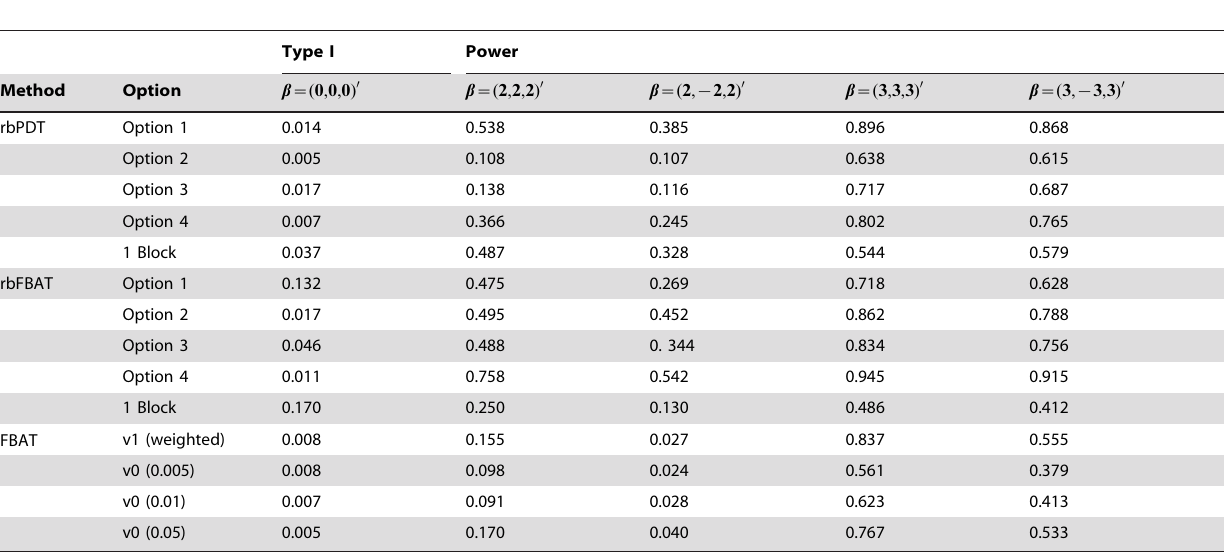
Table 1. Type 1 error and power results for the simulation based on a data set with 80